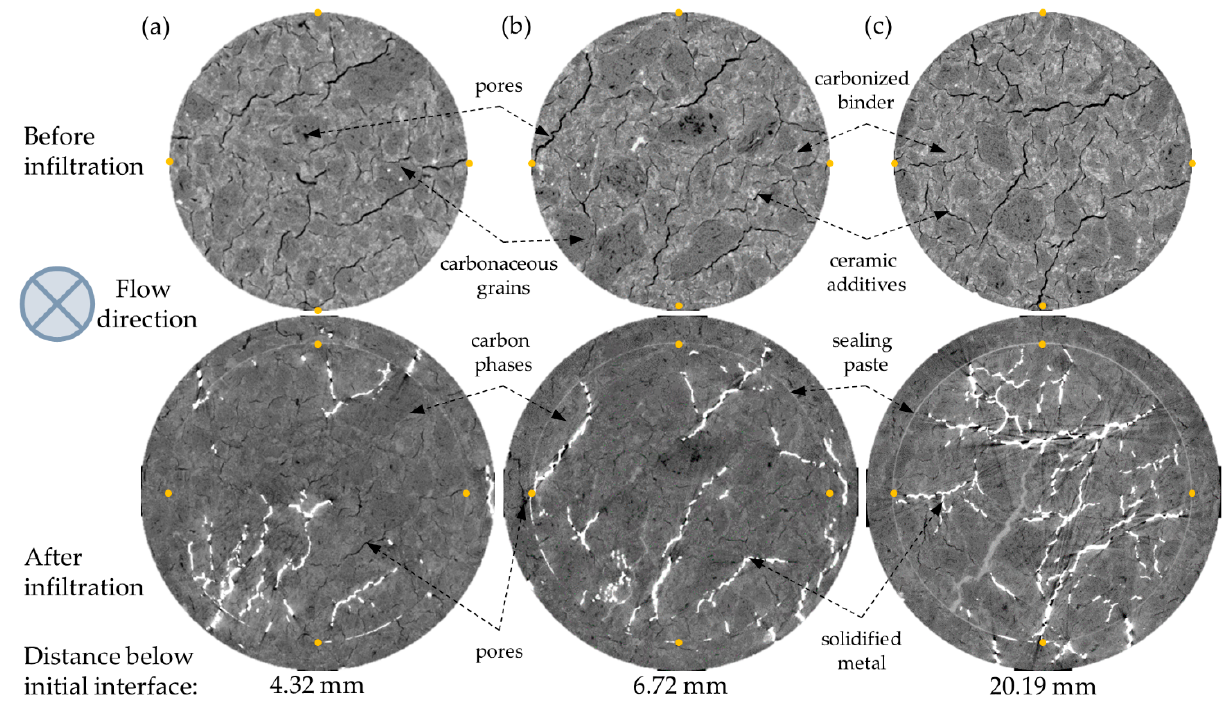
Figure 4. Two-dimensional cross-sections in the plane perpendicular to the molten metal flow of the sample before (top row) and after the HMP test (bottom row) at various distances from the initial molten metal/sample interface: ( a ) 4.32 mm ( b ) 6.72 mm and ( c ) 20.19 mm.